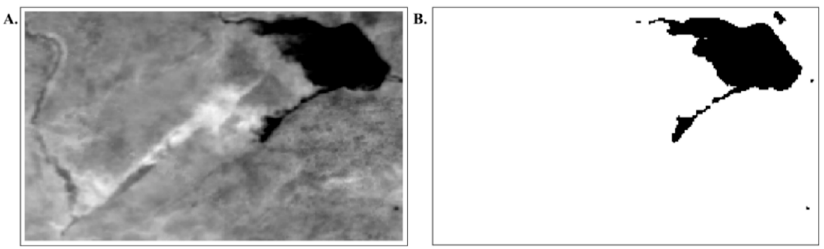
Figure 4. ( A ) Sample differenced MODIS Land Surface Temperature image for 16 May 2000 using the day and night LST bands; ( B ) Sample inundation extent extracted from differenced MODIS LST image using Otsu thresholding.